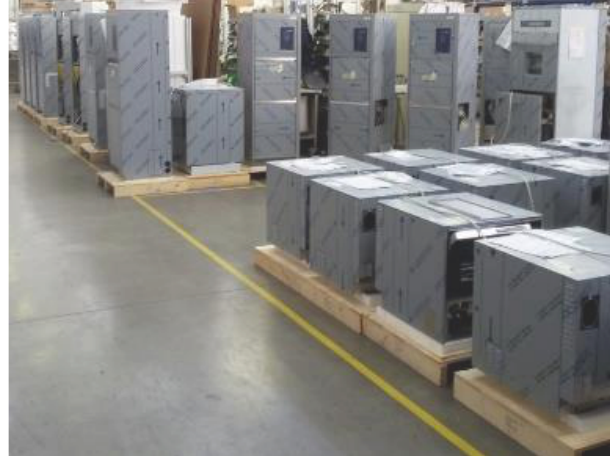
Figure 6. Example of case study part. Table 2. Case study a i and EPQ i